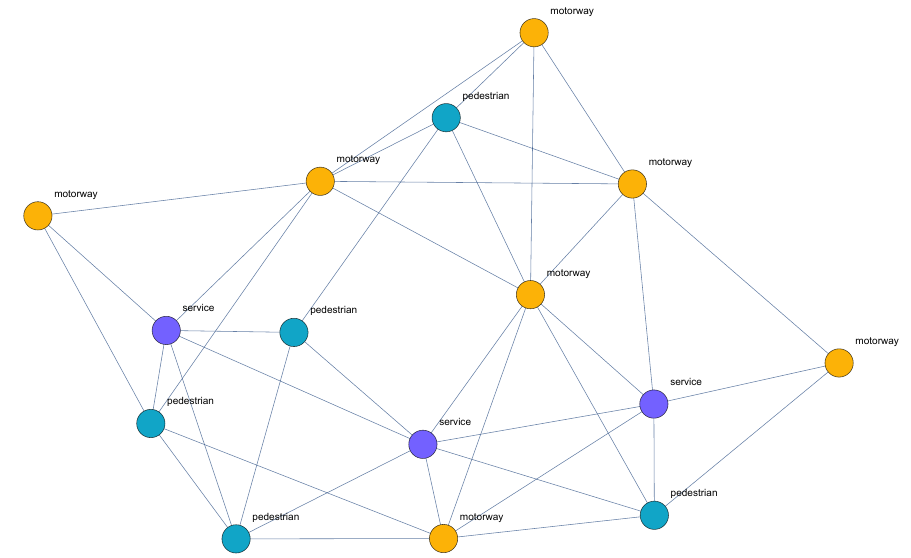
Figure 2. The corresponding line graph L